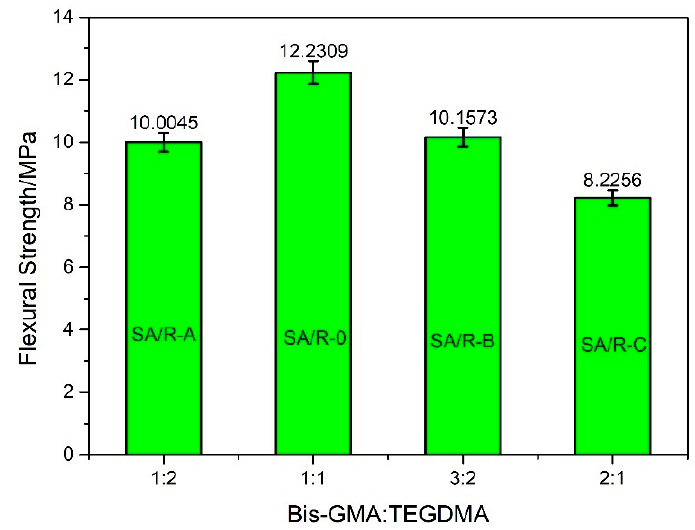
Figure 6. The flexural strength of blank samples, without silica aerogel, with different Bis-GMA: TEGDMA.